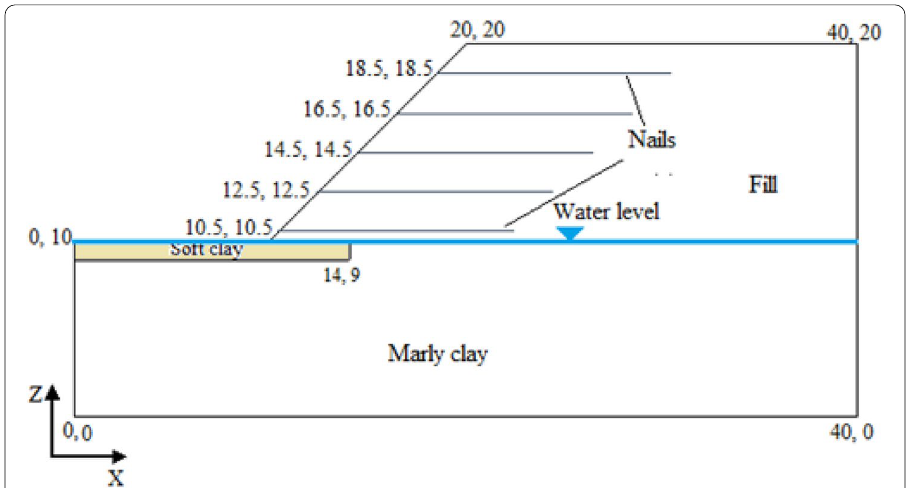
Fig. 1 Geometry of the soil nailed embankment slope model (all coordinates are in